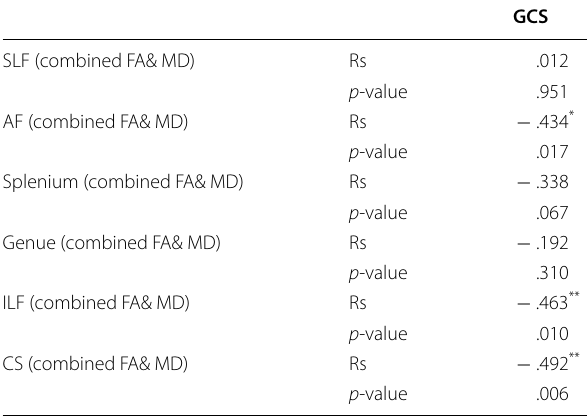
Table 6 Correlation between GCS and combined FA & MD among studied